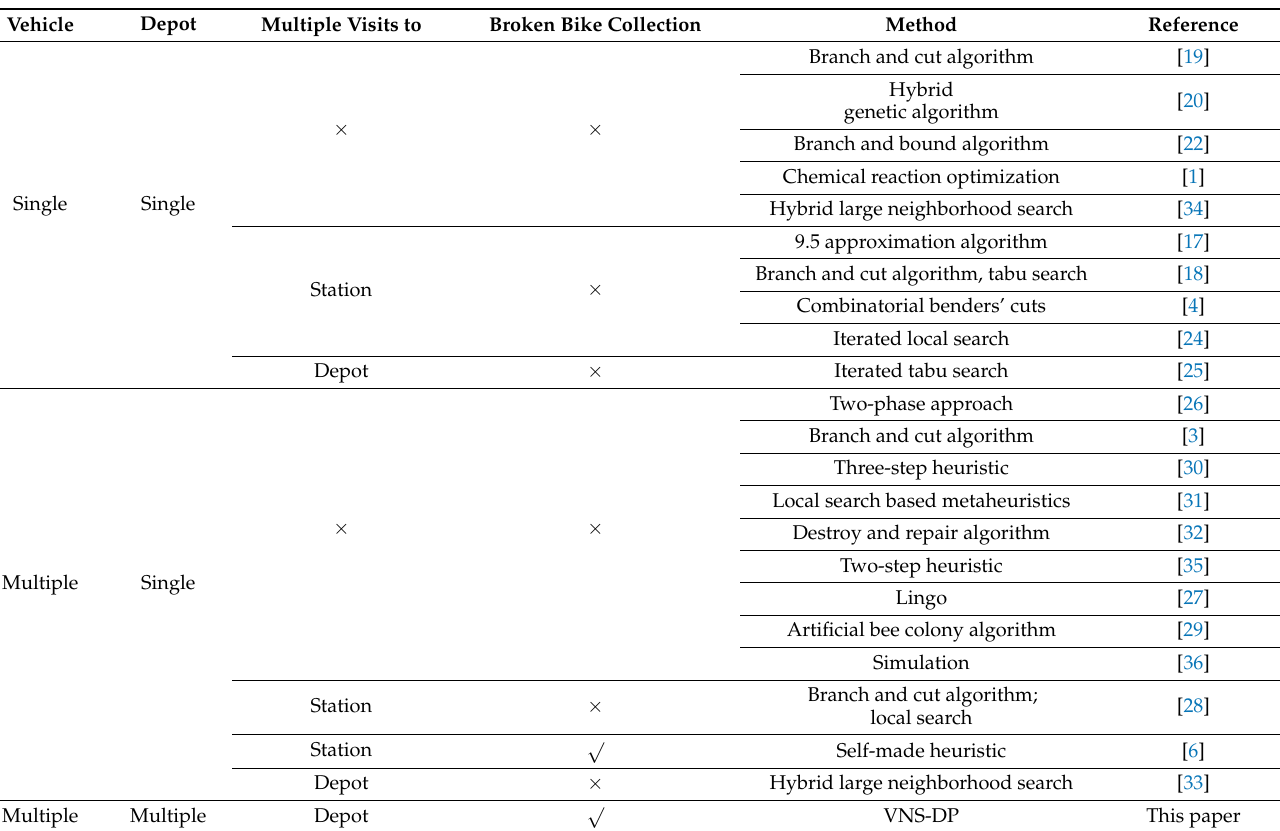
Table 1. Related publications on static bike rebalancing